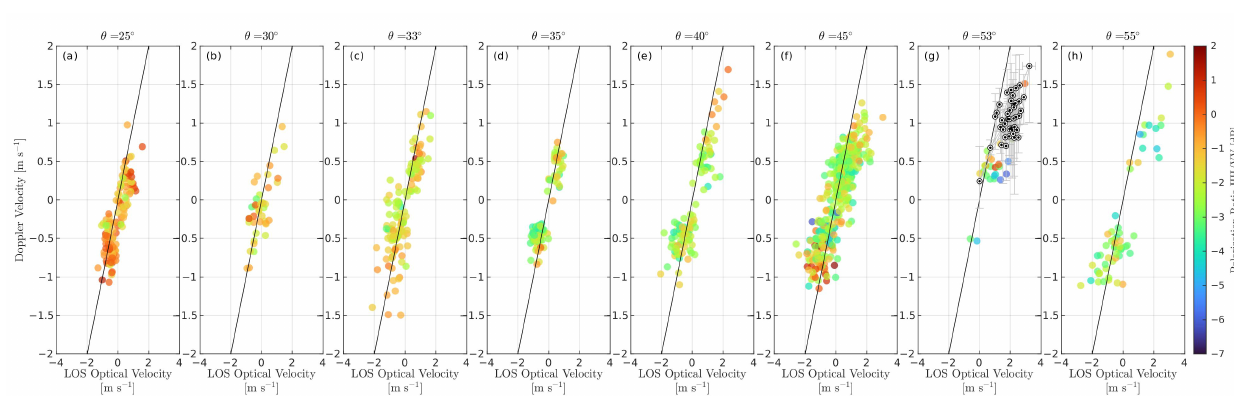
Figure 5. Scatterplots between the measured line-of-sight optical velocity (LOV) and Doppler velocity (DV) at VV polarization for the “average” dataset (with weights proportional to the whitecap footprint fraction) at different incidence angles: ( a ) θ = 25 ◦ , ( b ) θ = 30 ◦ , ( c ) θ = 33 ◦ , ( d ) θ = 35 ◦ , ( e ) θ = 40 ◦ , ( f ) θ = 45 ◦ , ( g ) θ = 53 ◦ , and ( h ) θ = 55 ◦ . Each point corresponds to a separate breaking event. The color of the symbols corresponds to the polarization ratio, HH/VV, in the logarithmic scale. The black symbols in ( g ) show the manual analysis data of the same dataset [52].